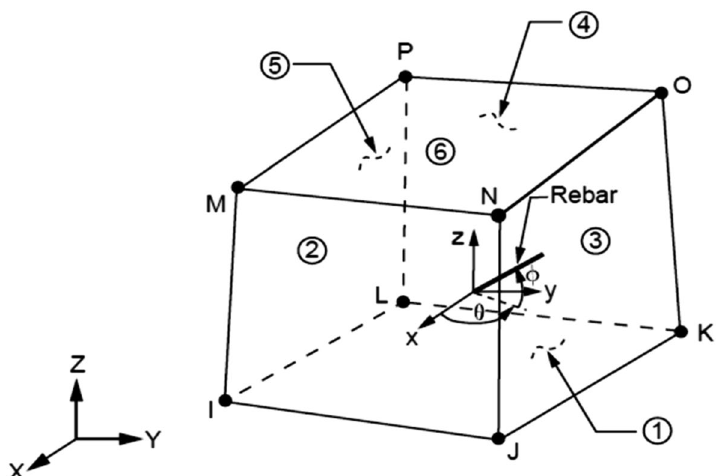
Fig. 9 Solid65 geometry, ANSYS